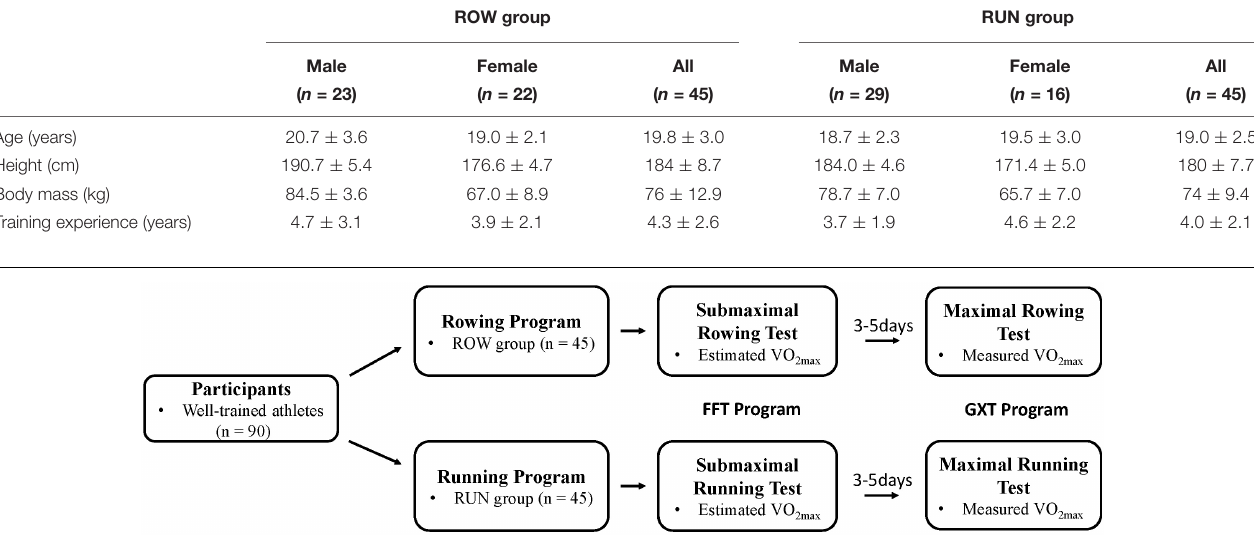
FIGURE 1 | Experimental tests